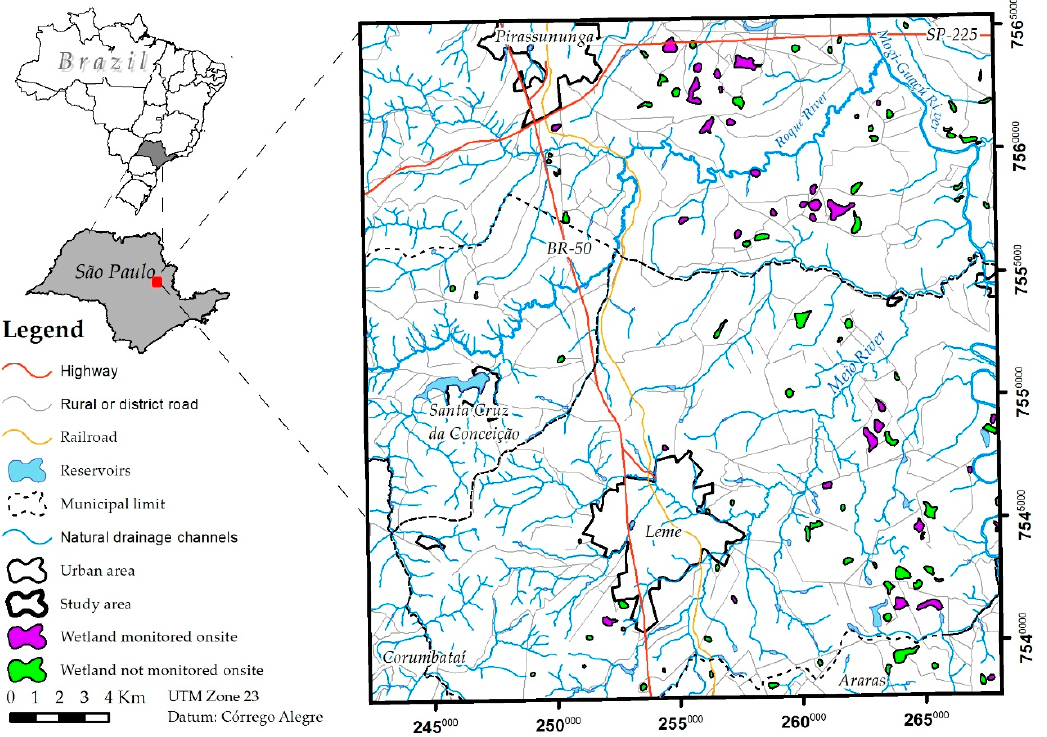
Figure 1. Location of the study region, wetlands, and main drainage channels.